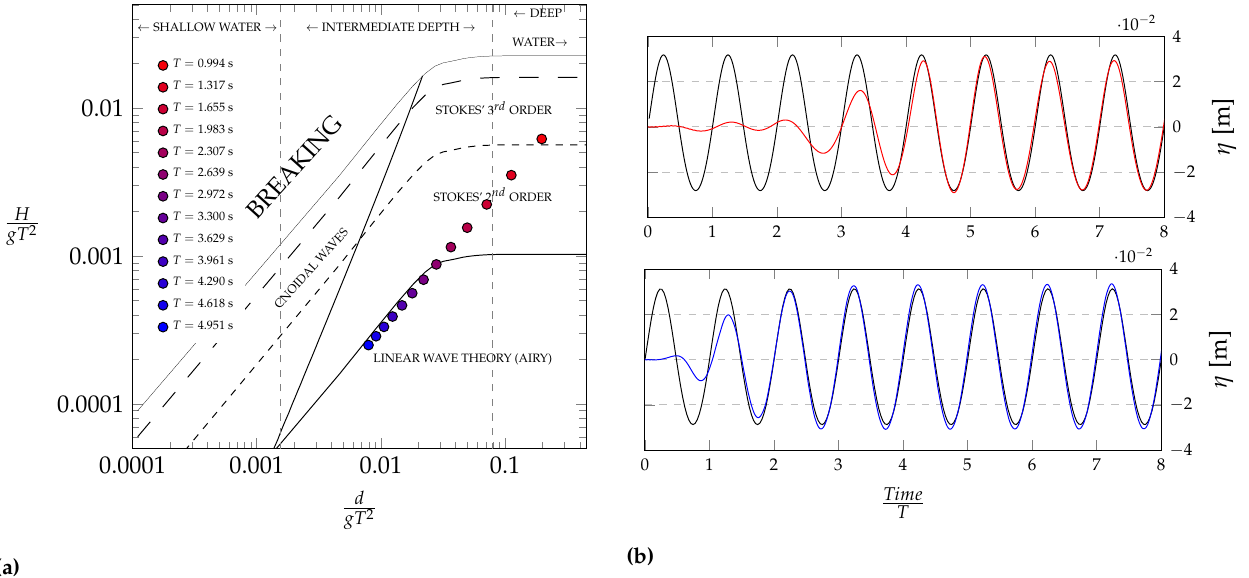
Figure 3. Regular wave conditions as classified in Le Méhauté abacus a. Surface elevation comparison between the generated wave and the theoretical second-order solutions (black solid lines) for the two extreme cases b.